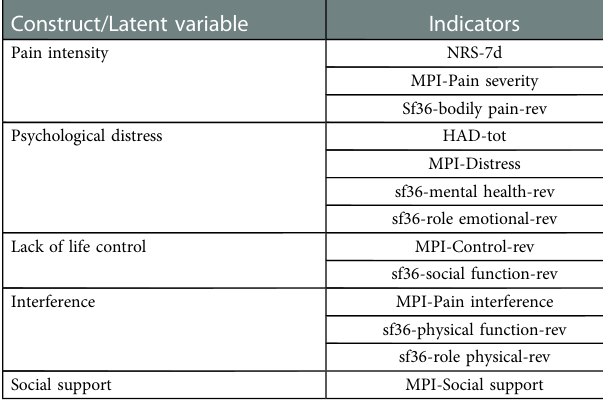
TABLE 2 Summary of constructs/latent variables and indicators included in the initial PLS-SEM analysis of the total cohort. Construct/Latent